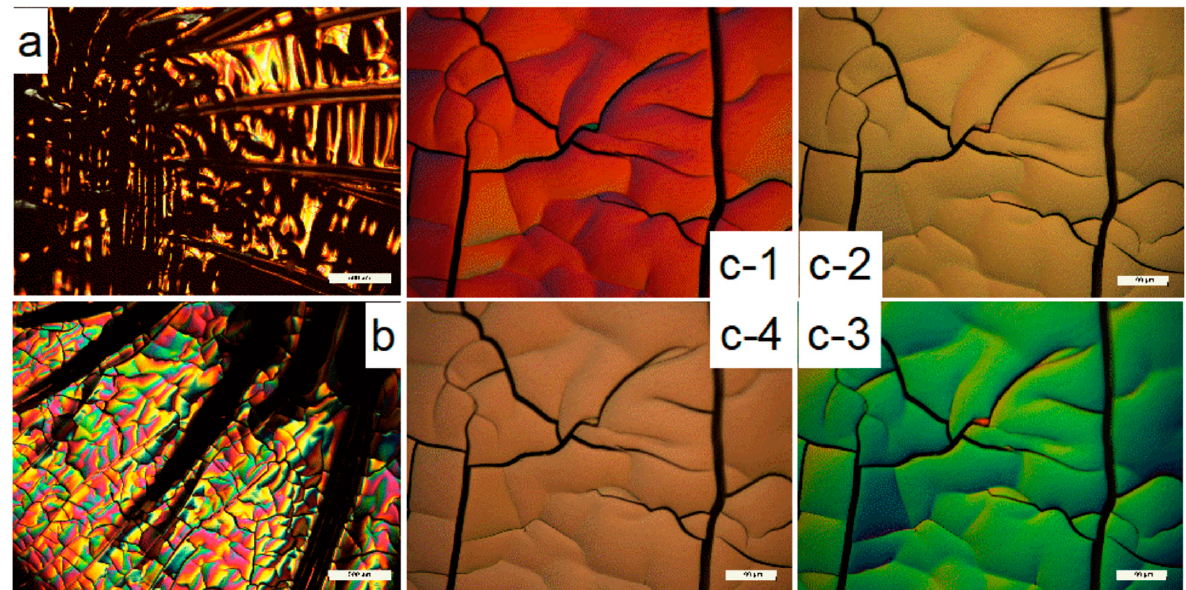
Figure 5. Polarized optical microscope images of lignin-based film without PEO and NCC and indicating different parts of the film have different optical properties ( a ) center, ( b ) edge of the film under lower magnification ( × 5, scale bar: 500 µ m), and ( c-1 – c-4 ) edge part of the film under the higher magnification ( × 20, scale bar: 100 µ m) with changing polarizer orientation from vertical ( c-1 ) to lateral direction ( c-4 ). Reprinted with permission from [144]. Copyright (2019) American Chemical Society.